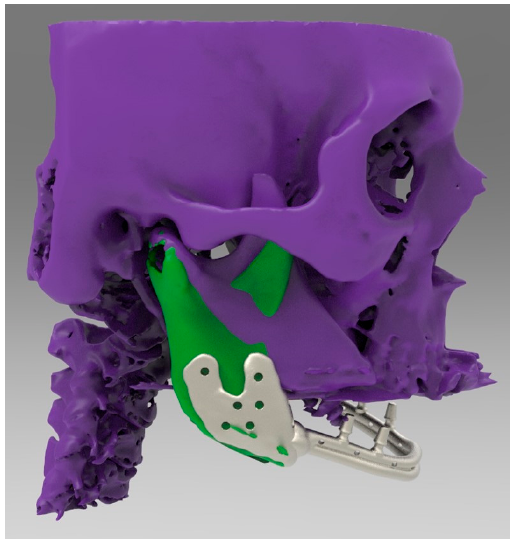
Figure 4. The preintervention computerized tomography (CT) was superimposed with the post CT in order to determine the original position of the mandible.